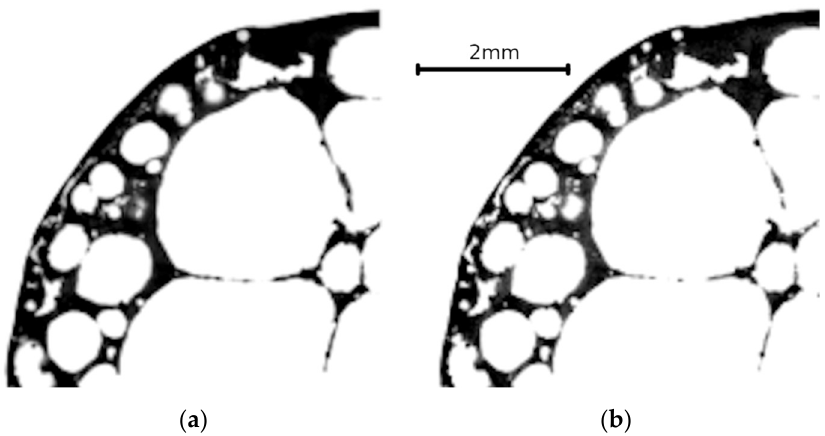
Figure 4. Undeformed APM sphere—transversal slices in the reconstructed 3D images of the high- quality reference CT scan ( a ) and the CT scan captured after the first loading step ( b ).